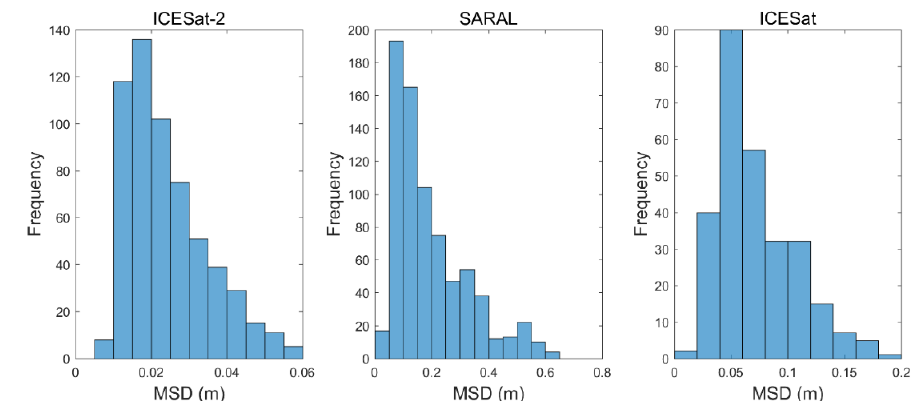
Figure 5. Frequency distribution of measurement uncertainty (MSD) for the ICESat-2, SARAL, and